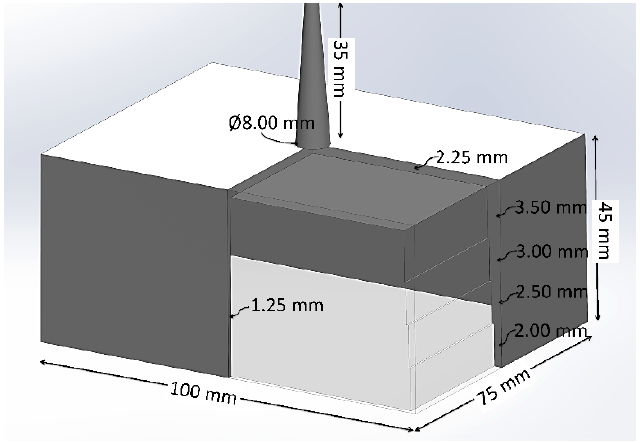
Figure 1. 3D model of the box-shaped part. A quarter of the part is cut away to show the variable wall thickness. Table 2. Processing parameters for solid CIM and MIM box-shaped